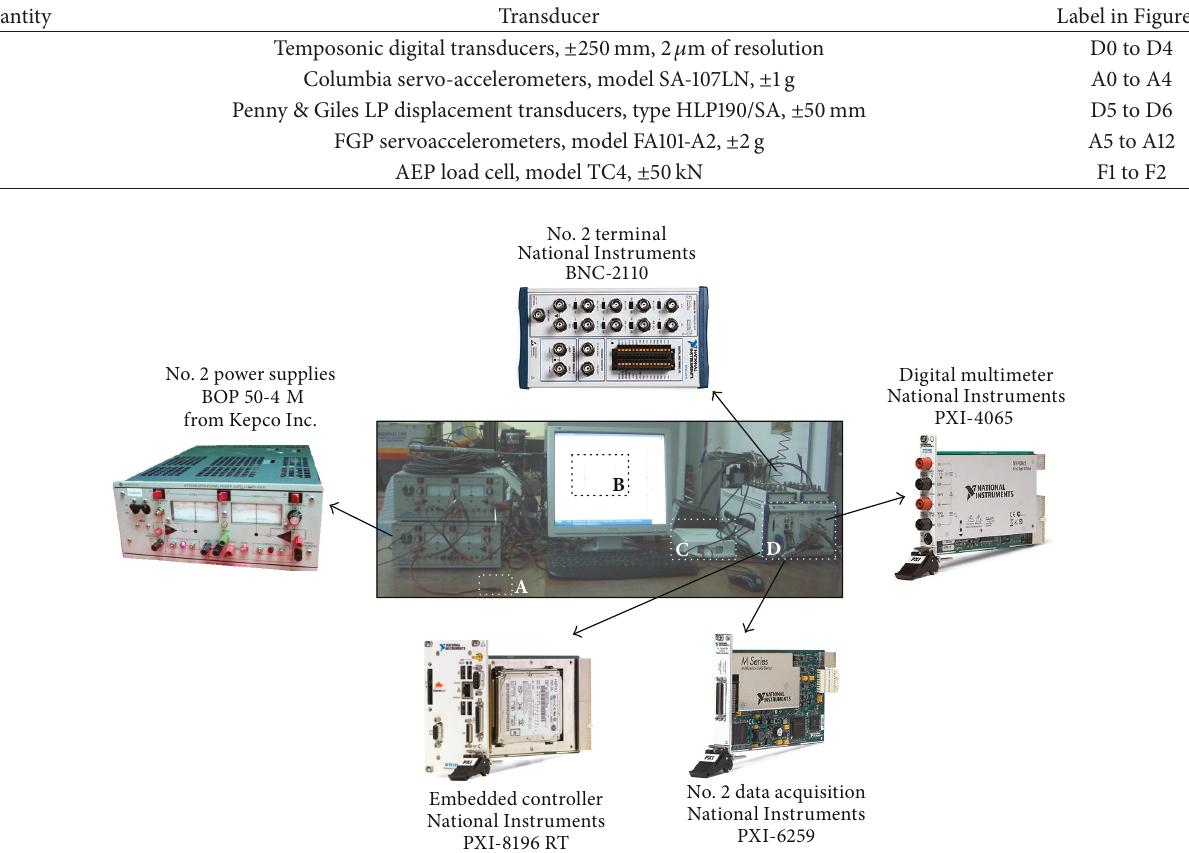
Figure 6: Electronic equipment for acquisition and control during the JET-PACS experimental